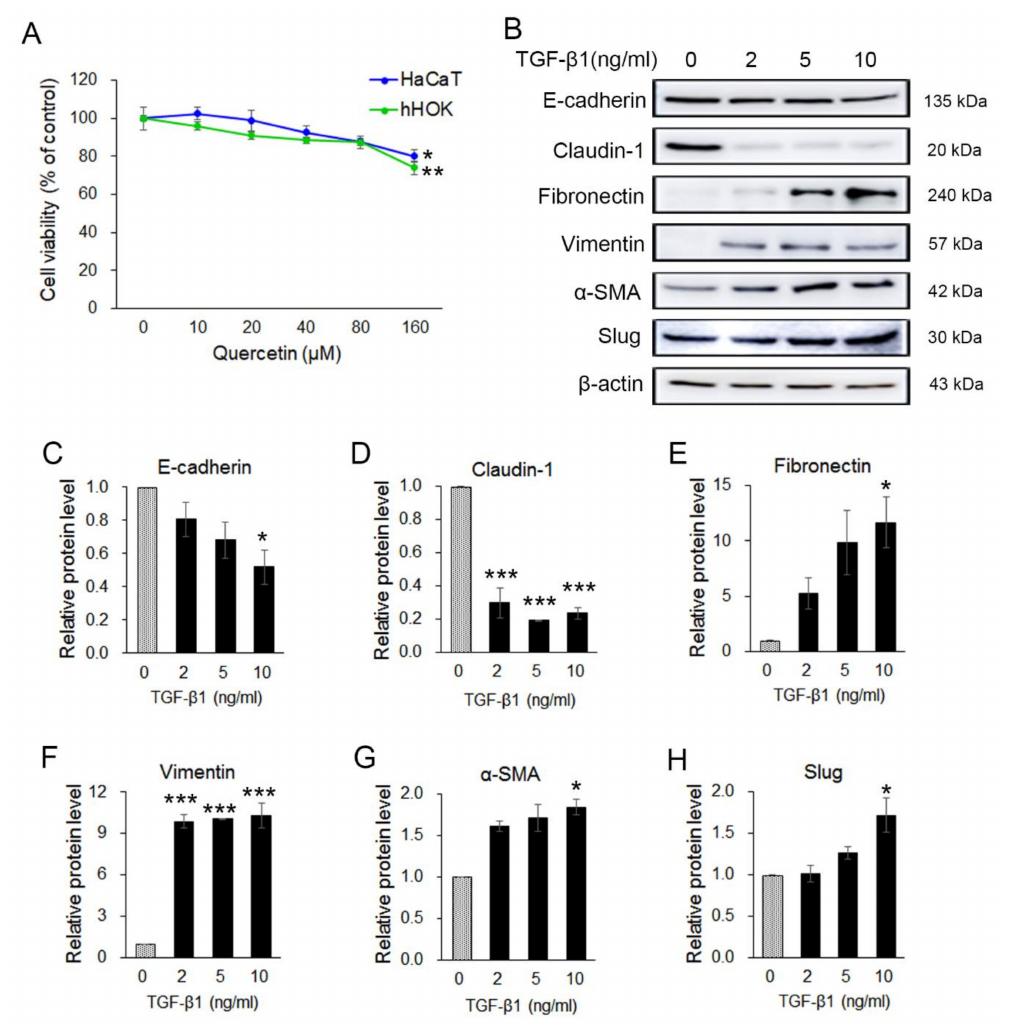
Figure 5. Quercetin was not toxic in normal keratocyte and transforming growth factor β 1 (TGF- β 1) stimulated EMT in HaCaT cells. ( A ) To examine the e ff ect of quercetin on cell viability, an MTT